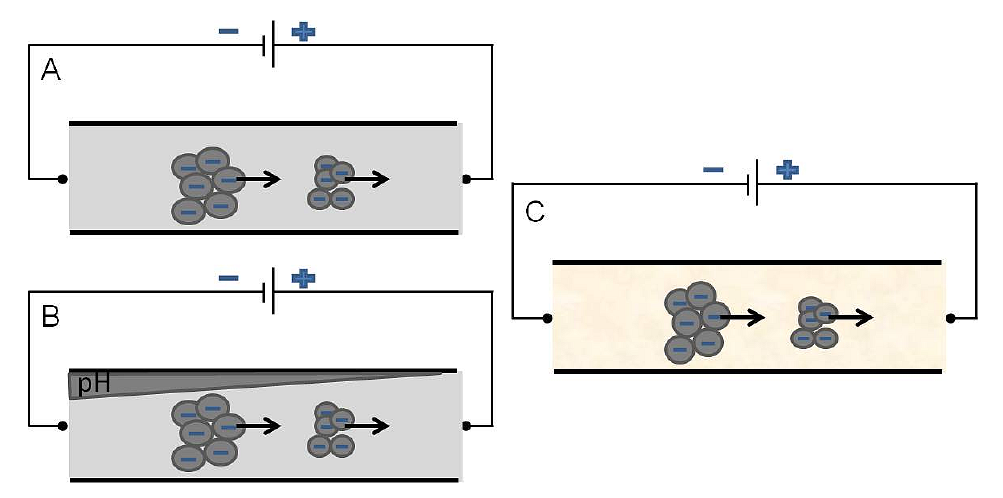
Figure 2. Electrophoresis approaches within microfluidic systems. ( A ) Sample movement in free solution; ( B ) Electrofocusing; ( C ) Gel